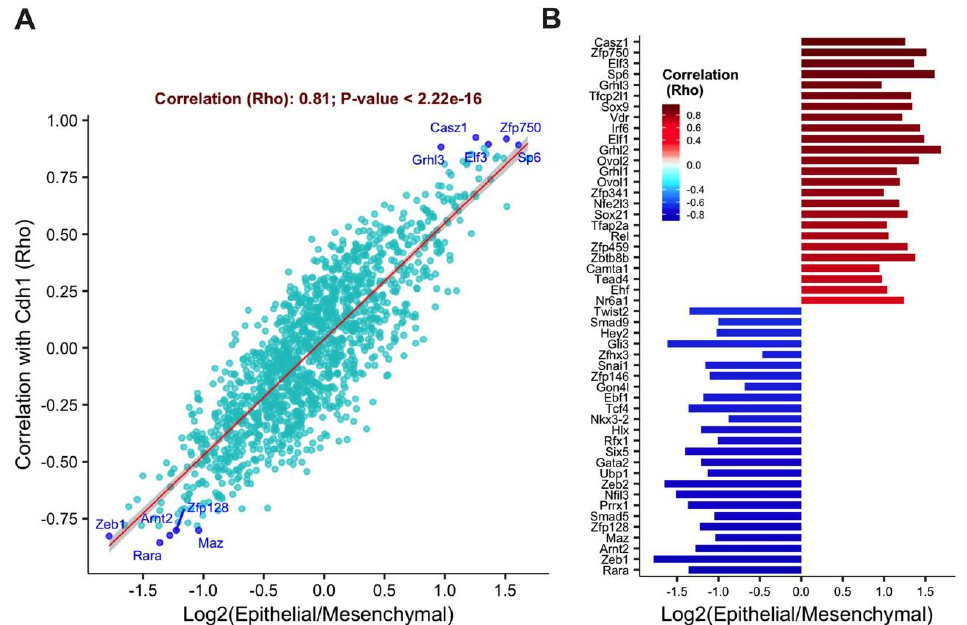
Figure 1. The transcription factors Elf3 and Grhl3 are highly correlated with the epithelial state. ( A ) A scatter plot that shows the correlation of 1469 transcription factors with the epithelial phenotype. Microarray-based screen for epithelial-specific transcription factors coregulated with E-cadherin. One-thousand-four-hundred-and-sixty-nine transcription factors were analyzed for di ff erential expression in epithelial compared to mesenchymal samples, and Spearman correlation was calculated between each transcription factor and E-cadherin across all data sets. The top 5 correlated genes with either the epithelial or the mesenchymal phenotypes are labeled. ( B ) The ranking plot is displaying the top 25 correlated transcription factors in the epithelial and in the mesenchymal states. The x-axis represents the di ff erential expression of each transcription factor in epithelial versus mesenchymal